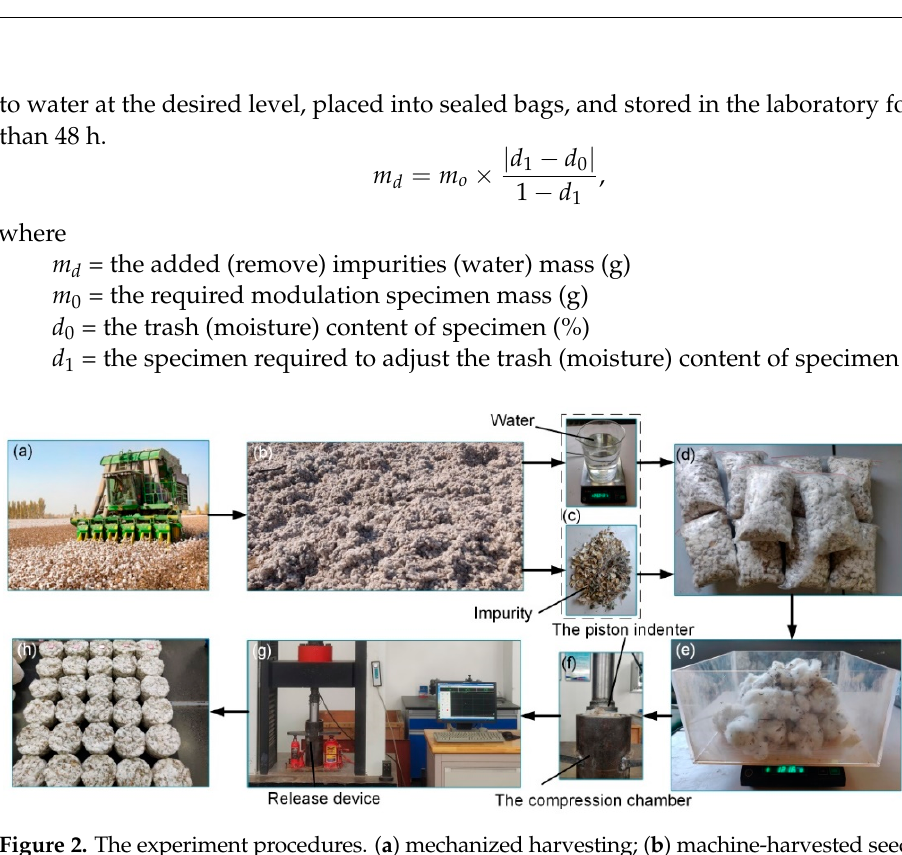
Figure 2. The experiment procedures. ( a ) mechanized harvesting; ( b ) machine-harvested seed cotton sampling; ( c ) rehydration (adding impurities) treatment machine-harvested seed cotton samples; ( d ) processed samples; ( e ) feeding quality control; ( f ) guarantee of initial density; ( g ) machine-harvested seed cotton compresses and strain remains 300 s; ( h ) machine-harvested seed cotton molding.